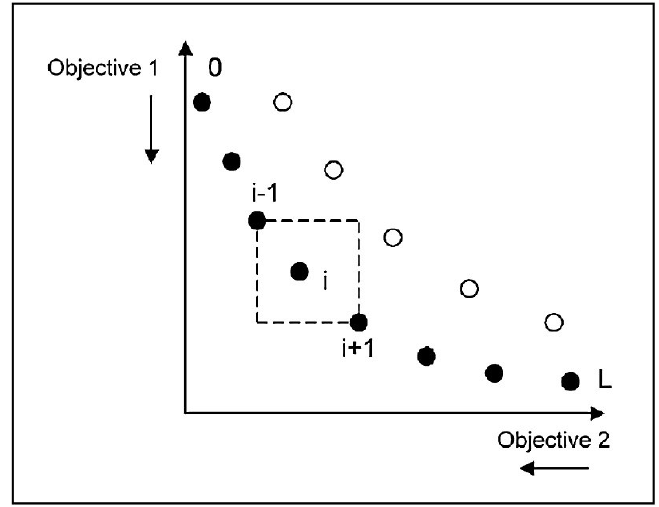
Figure 1. Schematic illustration of crowding distance criterion (Boloori Arabani, Zandieh & Ghomi, 2011)